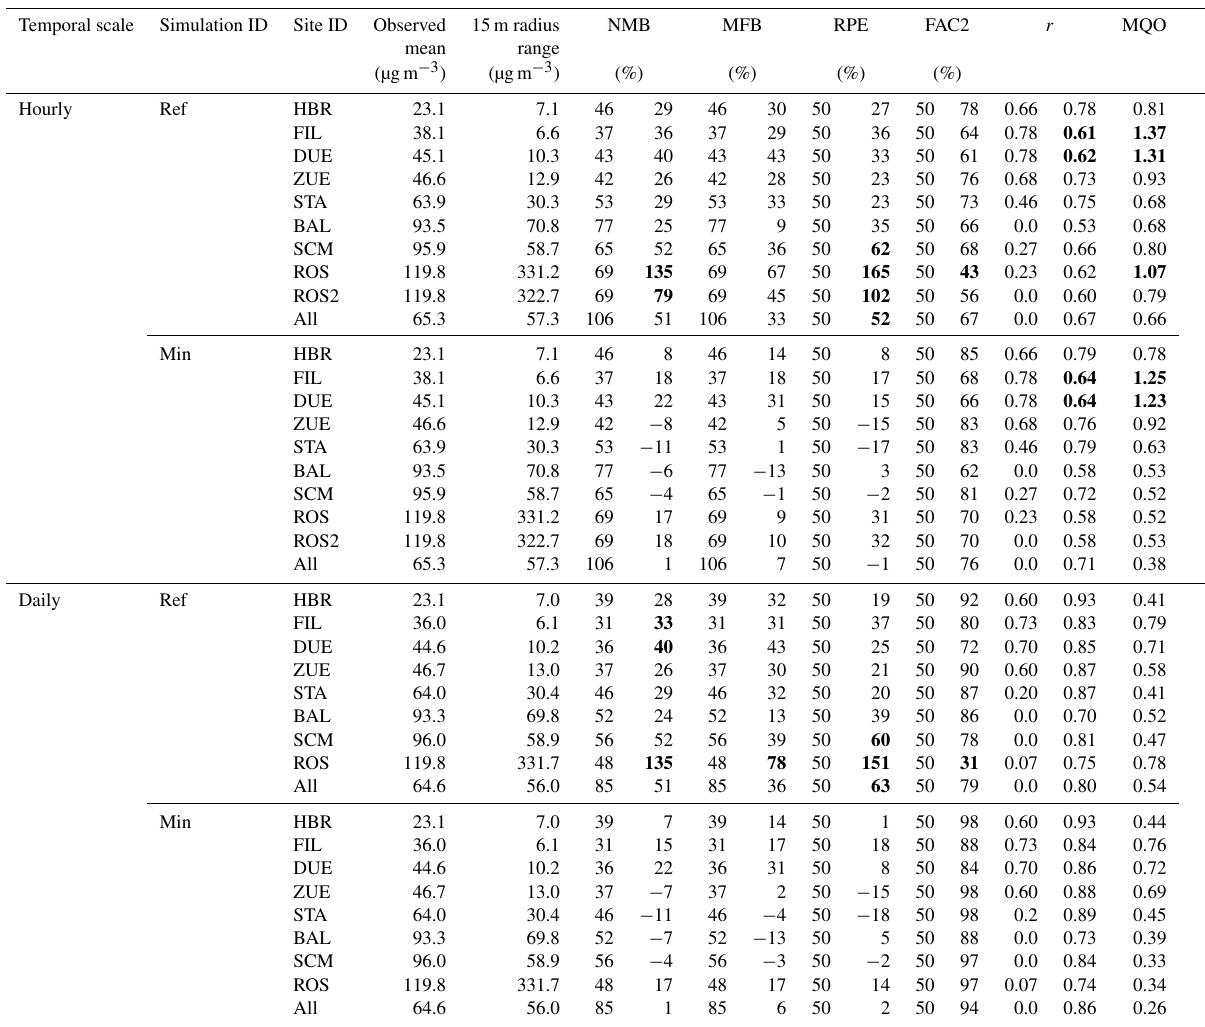
Table 2. Model performance for NO x concentrations at all observation sites on the hourly and daily scales. Ref = standard simulation at the exact location of observation sites. Min = simulated minimum in a radius of 15m horizontally and 2m vertically. The score metrics are defined in Sect. 2.3. The left column for each score represents the FAIRMODE performance objective (defined in Sect. 2.3) following Thunis et al. (2012) dependent on U ; the right column is the computed score. Values not fulfilling the FAIRMODE objective are reported in bold. Sites are sorted by increasing observed